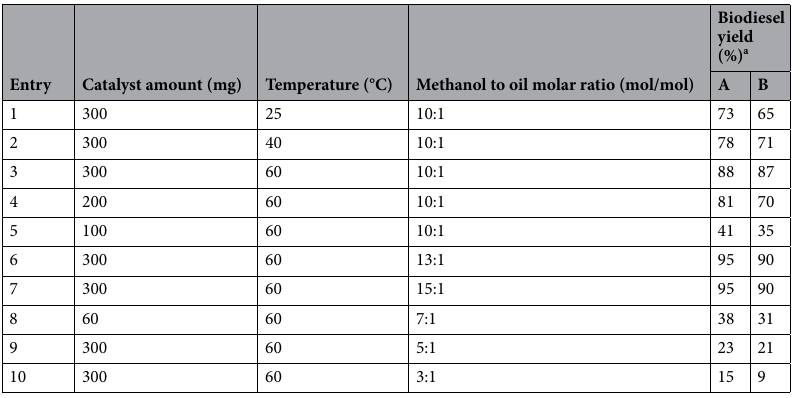
Table 2. Experimental data for the optimized yield of biodiesel from oleic acid(A) and palmitic acid(B) with methanol in presence of Mo–MOF. a Reaction time(4 h), Isolated yield.